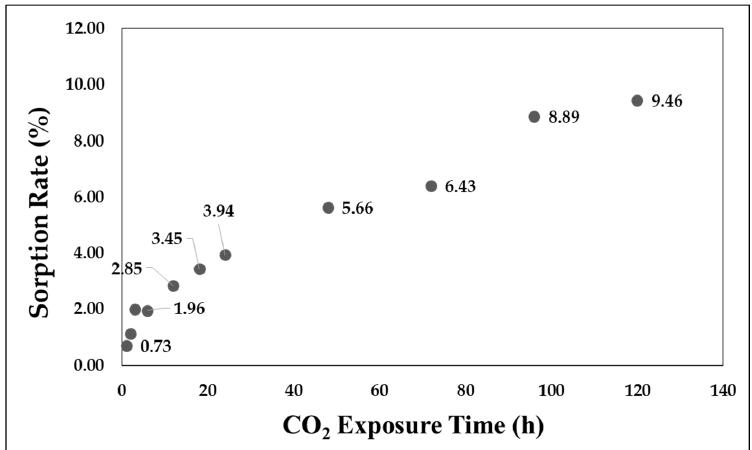
Figure 7. Relationship between impact strength and sorption rate.